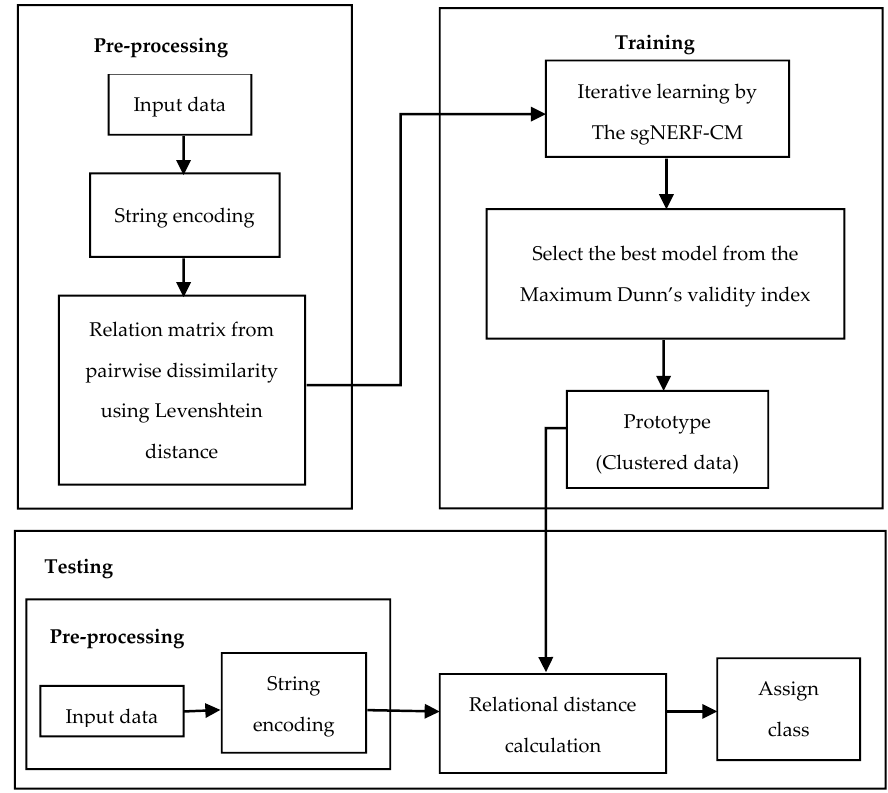
Figure 1. System description.